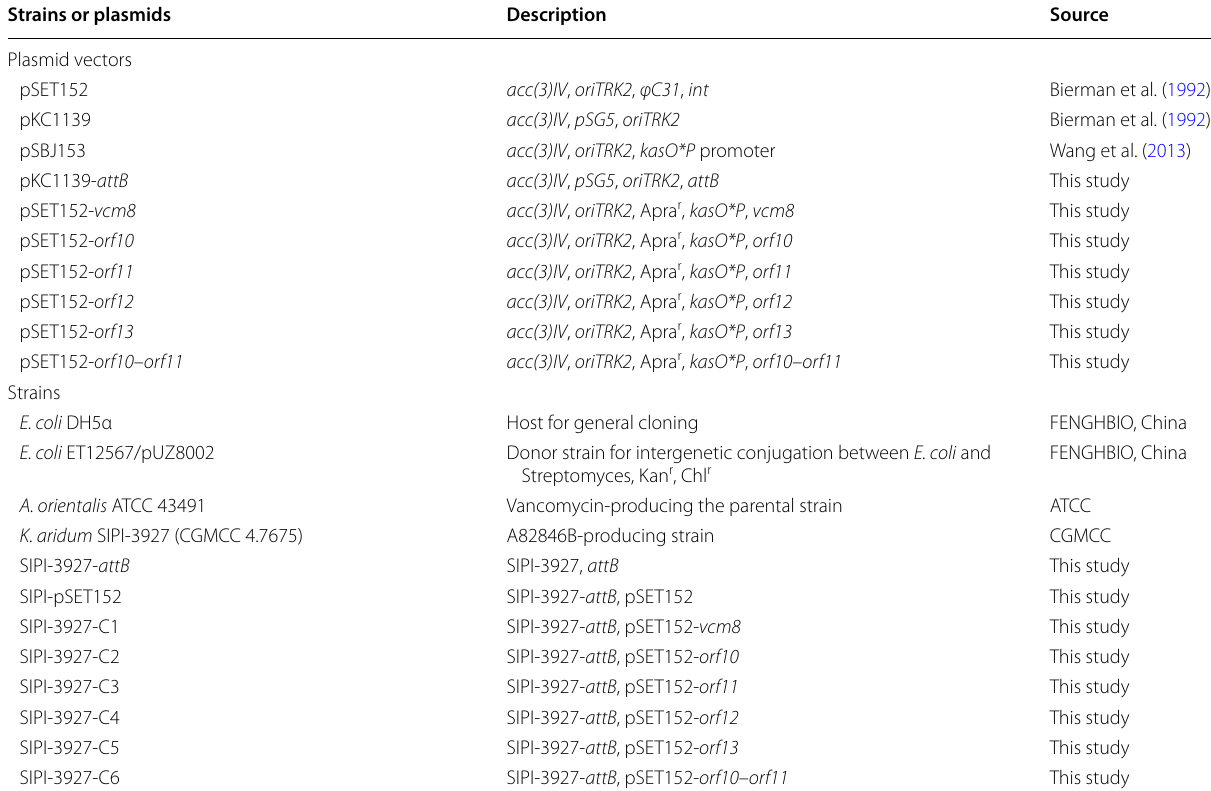
Table 1 Bacterial strains and plasmids Strains or plasmids